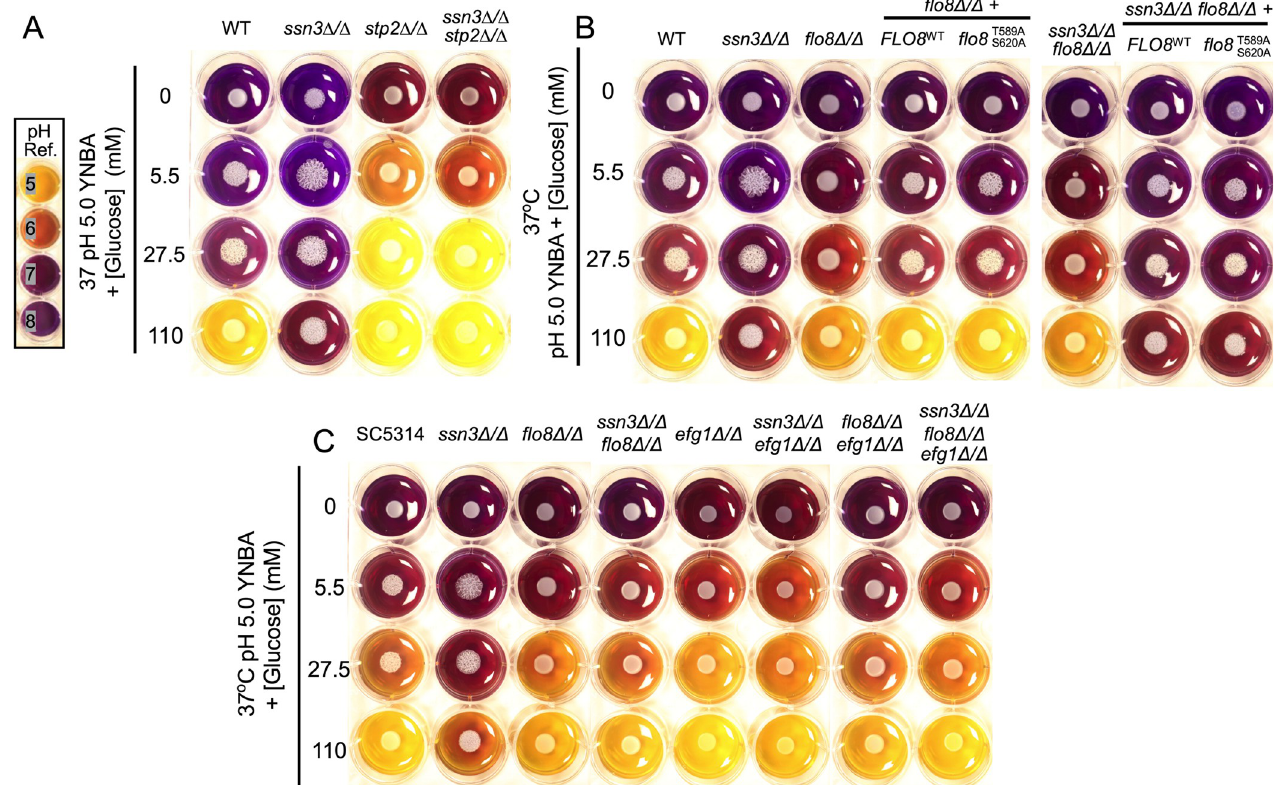
Fig 7. Medium alkalinization by Ssn3 is dependent on Stp2, Flo8, and Efg1. Medium pH was assessed on YNBA with increasing concentrations of glucose; bromocresol purple was added as a pH indicator. All cultures were incubated at 37˚C. A. Comparison of medium pH upon growth of SC5314 (WT), ssn3 Δ / Δ , stp2 Δ / Δ and ssn3 Δ / Δ stp2 Δ / Δ strains. B. WT, ssn3 Δ / Δ , flo8 Δ / Δ and ssn3 Δ / Δ flo8 Δ / Δ alone or complemented with C-terminally 3XHA-tagged Flo8 WT or Flo8 T589A/S620A were grown as described above. C. WT, ssn3 Δ / Δ , flo8 Δ / Δ and ssn3 Δ / Δ flo8 Δ / Δ were compared to efg1 Δ / Δ , ssn3 Δ / Δ efg1 Δ / Δ , flo8 Δ / Δ efg1 Δ / Δ ,and ssn3 Δ / Δ flo8 Δ / Δ efg1 Δ / Δ